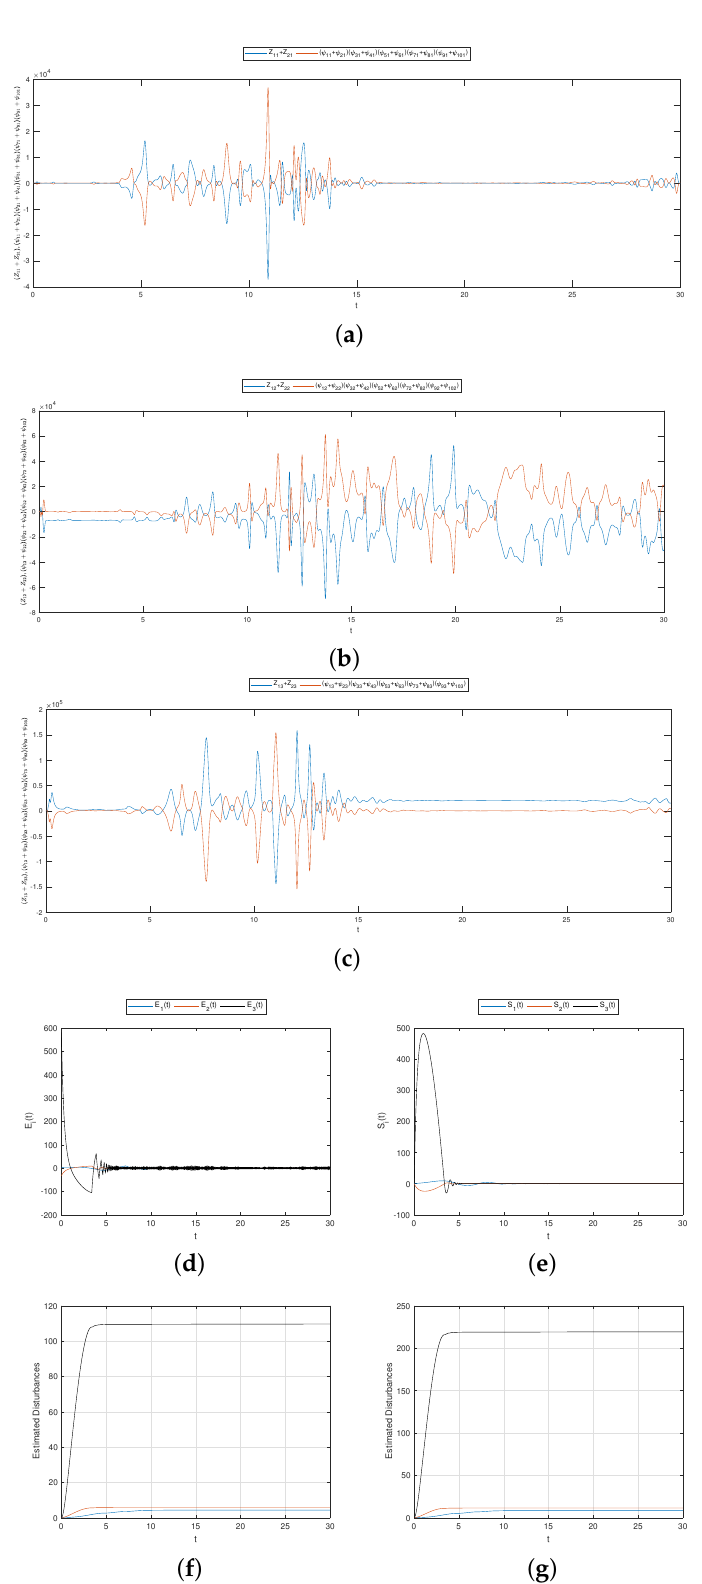
Figure 8. ( a – c ) Synchronized trajectories via adaptive sliding mode control. ( d ) Error. ( e ) Surface converging to zero. ( f , g ) Disturbance